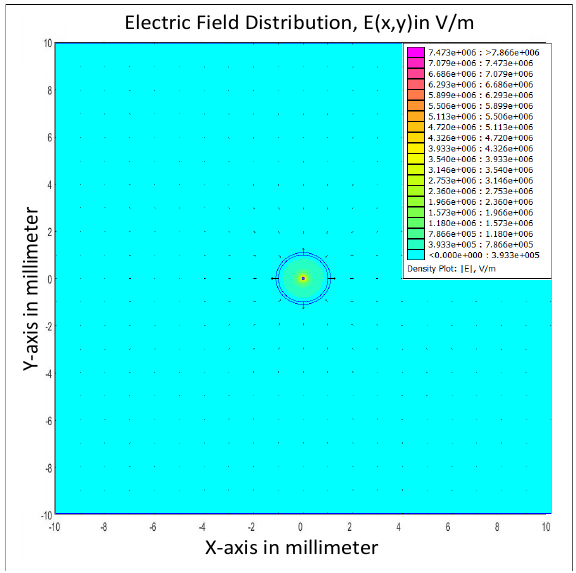
Figure 9. Tlectric field distribution of the proposed device when (cid:101) r =